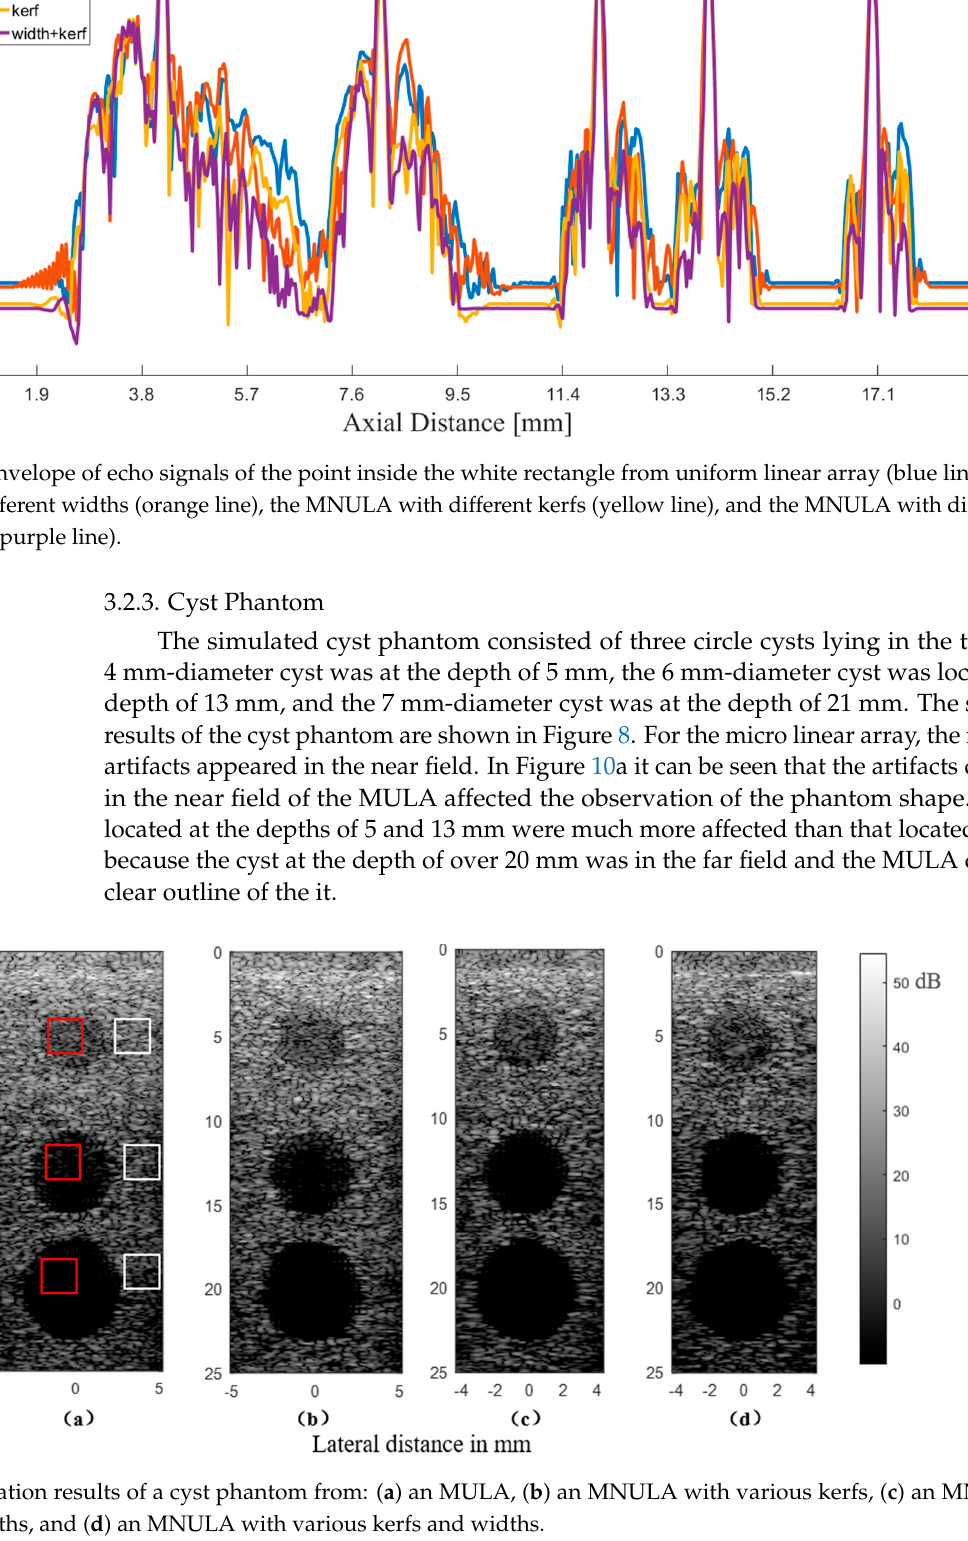
Figure 8. Lateral envelope of echo signals of the points inside the red rectangle from the uniform linear array (blue line), the MNULA with different widths (orange line), the MNULA with differ- ent kerfs (yellow line), and the MNULA with different kerfs and width (purple line).